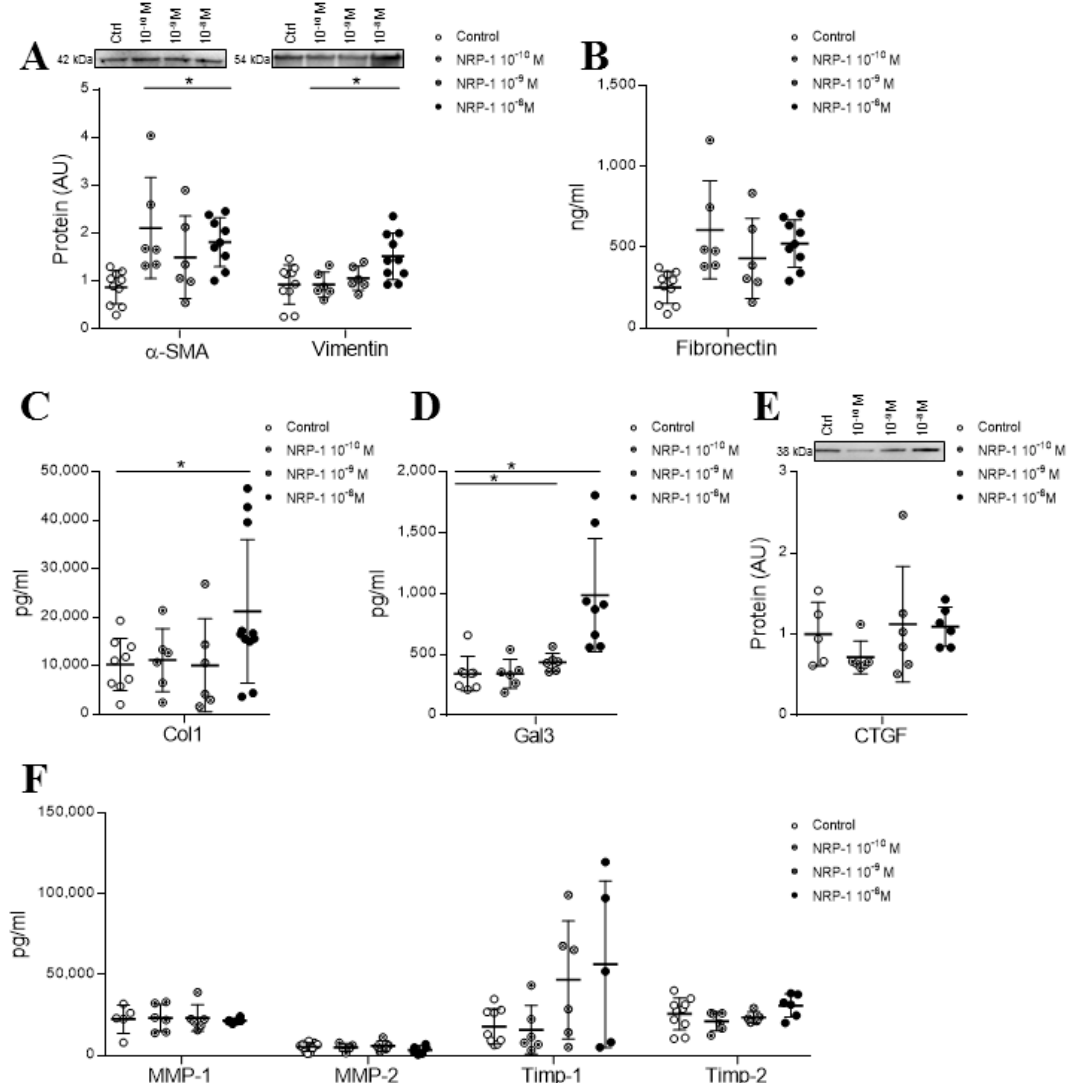
Figure 4. Effect of exogenous NRP-1 on fibroblast activation and profibrotic marker expressions in adult HCFs. Dose-dependent effects of exogenous NRP-1 were studied at a 24-h time point on myofibroblast activation markers α -SMA and vimentin ( A ); fibronectin ( B ); Col-1 secretion ( C ); profibrotic markers Gal-3 ( D ) and CTGF ( E ) and MMP-1, MMP-2, TIMP-1 and TIMP-2 ( F ). Scatter dot blot represents the median and minimum to a maximum range of N = 5-11 replicates per condition. For Western blot experiments, protein densitometry was expressed in arbitrary units (AU) once normalized to stain-free for proteins. Representative blots have been displayed when appropriate. * p < 0.05 vs. control group. α -SMA, alpha smooth muscle actin; Col-1, collagen type I; Gal-3, galectin-3; CTGF, connective tissue growth factor; MMP, metalloproteinase and TIMP, tissue inhibitor of metalloproteinase.